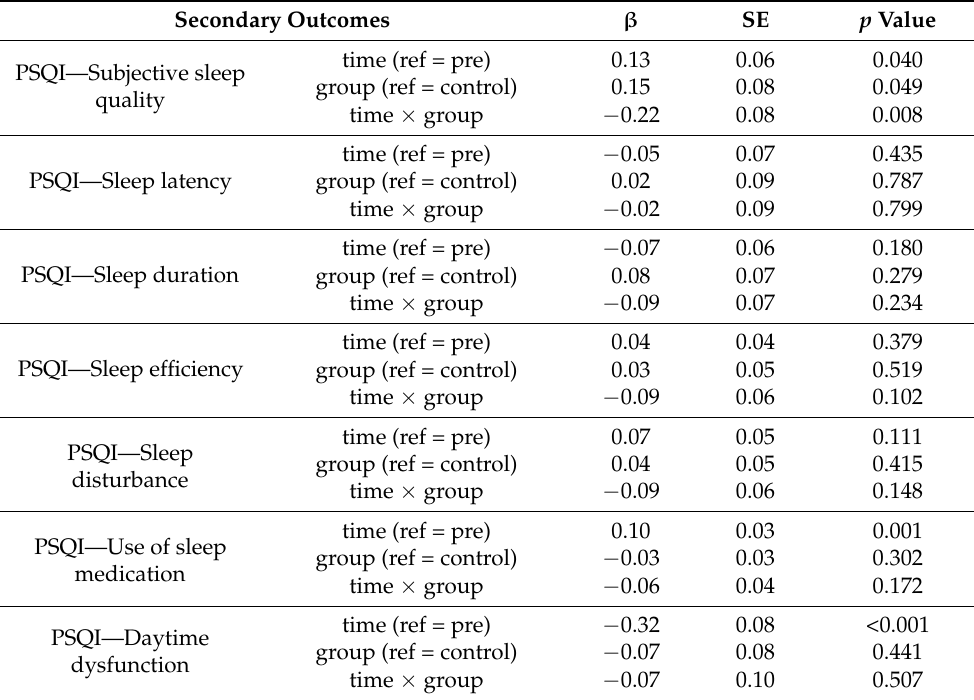
Table 4. Linear mixed-effects models of intervention effect on secondary